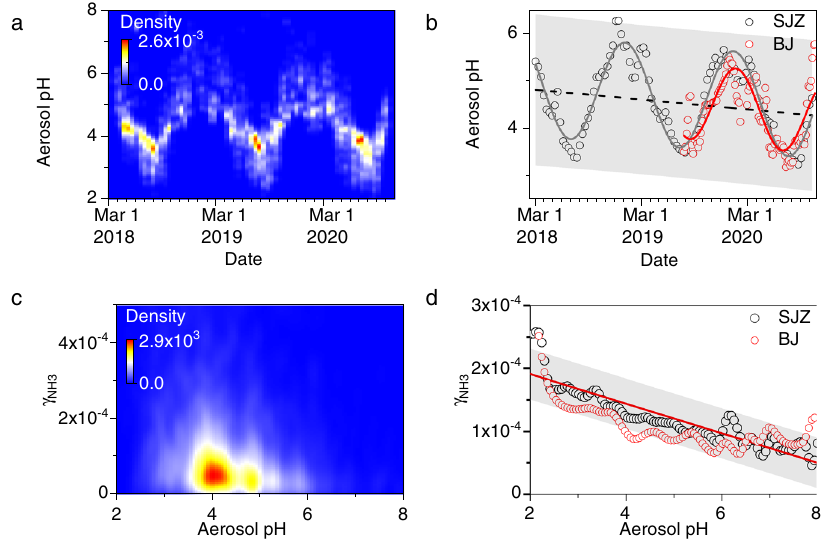
Fig. 3 | The aerosol pH and its correlation with nocturnal uptake coef fi cient of NH 3 ( γ NH3 ). a The probability distribution of the nocturnal aerosol pH in Shi- jiazhuang (SJZ), b the probability-weighted nocturnal aerosol pH in Shijiazhuang